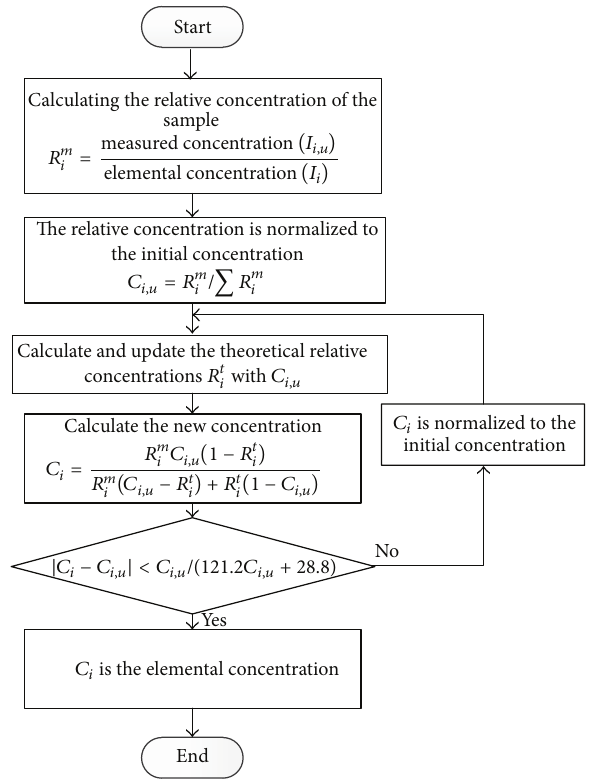
Figure 6: Steps of quantitative analysis, where 𝑚 is the measured value and 𝑡 is the calculated value.